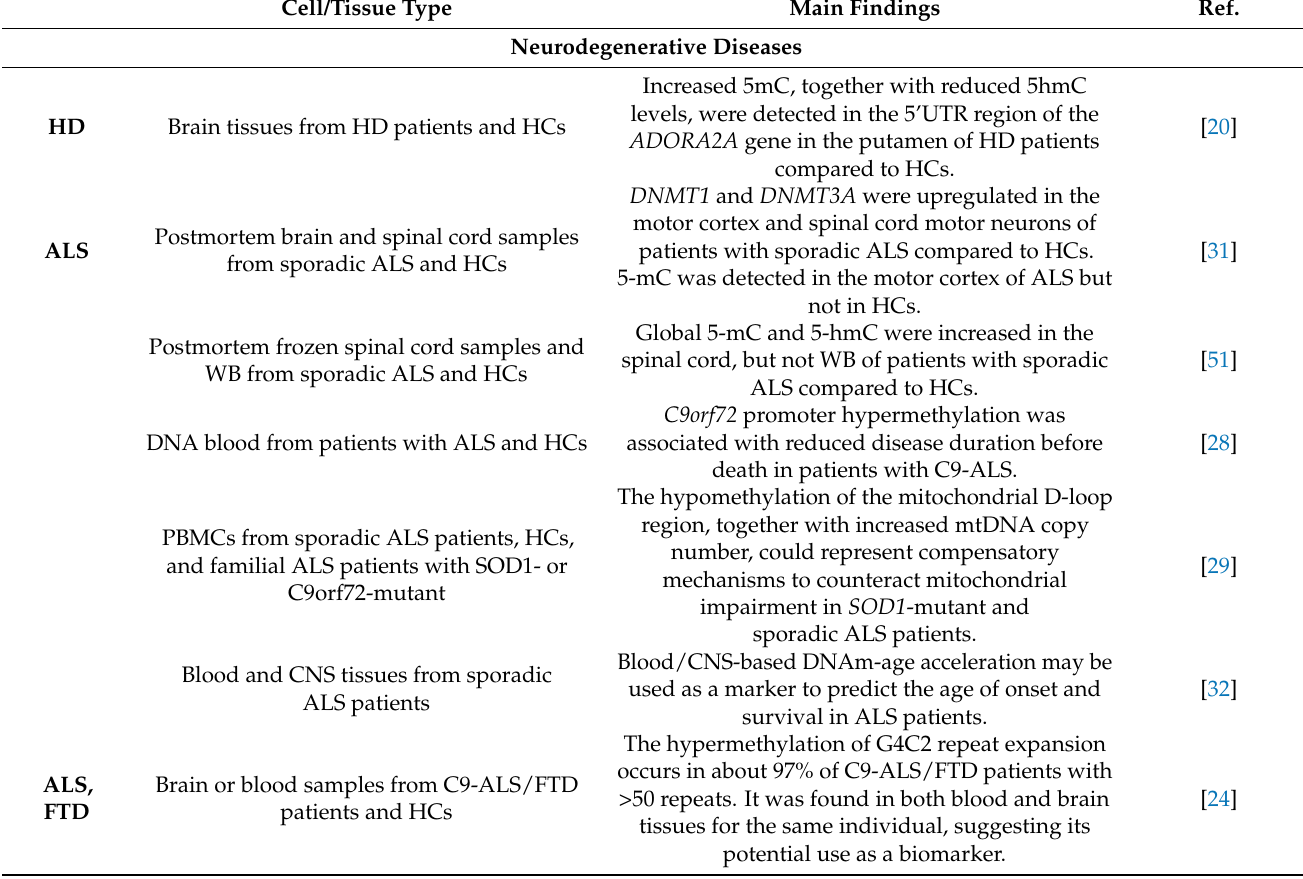
Table 1. Potential DNA methylation markers in neurodegenerative diseases. Cell/Tissue Type Main Findings